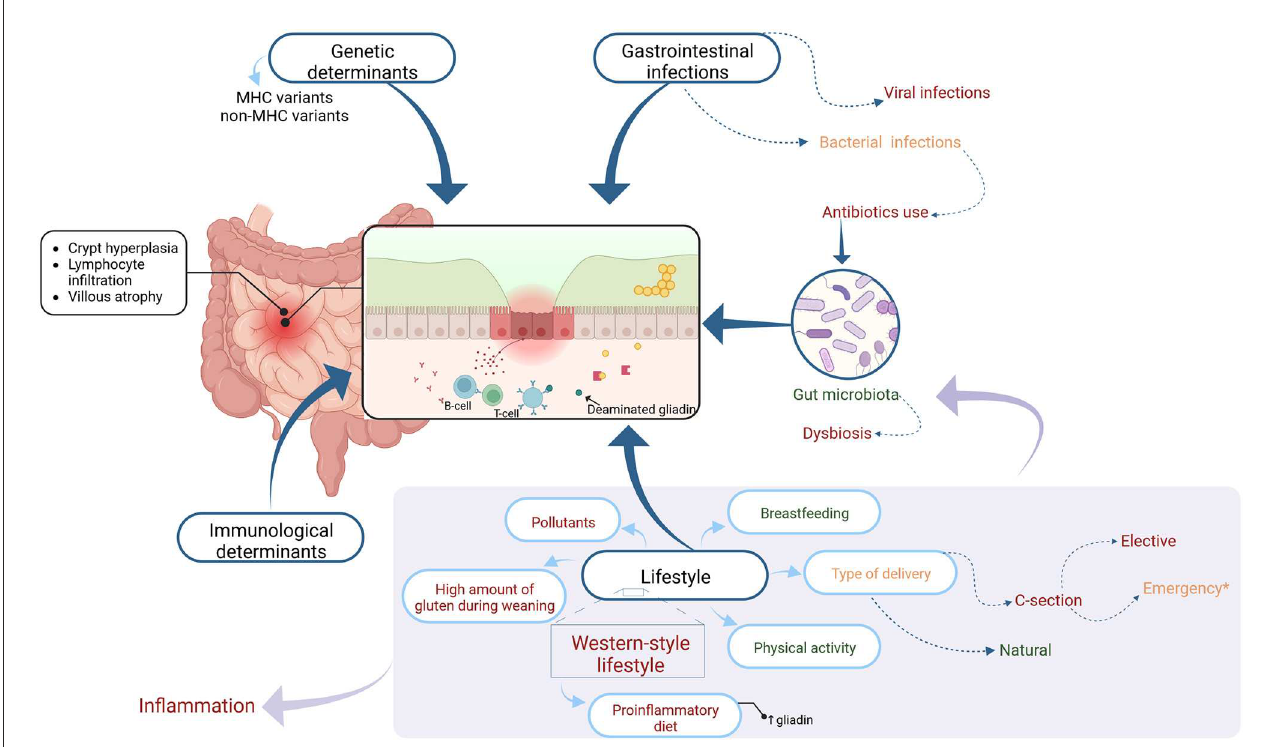
FIGURE1 The figure shows the factors influencing and potentially influencing the development of celiac disease marked in color as appropriate: general factors-black, factors showing a potentially protective effect-green, factors negatively influencing the development of celiac disease-red, and factors that may have a dual effect-orange. Each group of factors is discussed in further detail in the